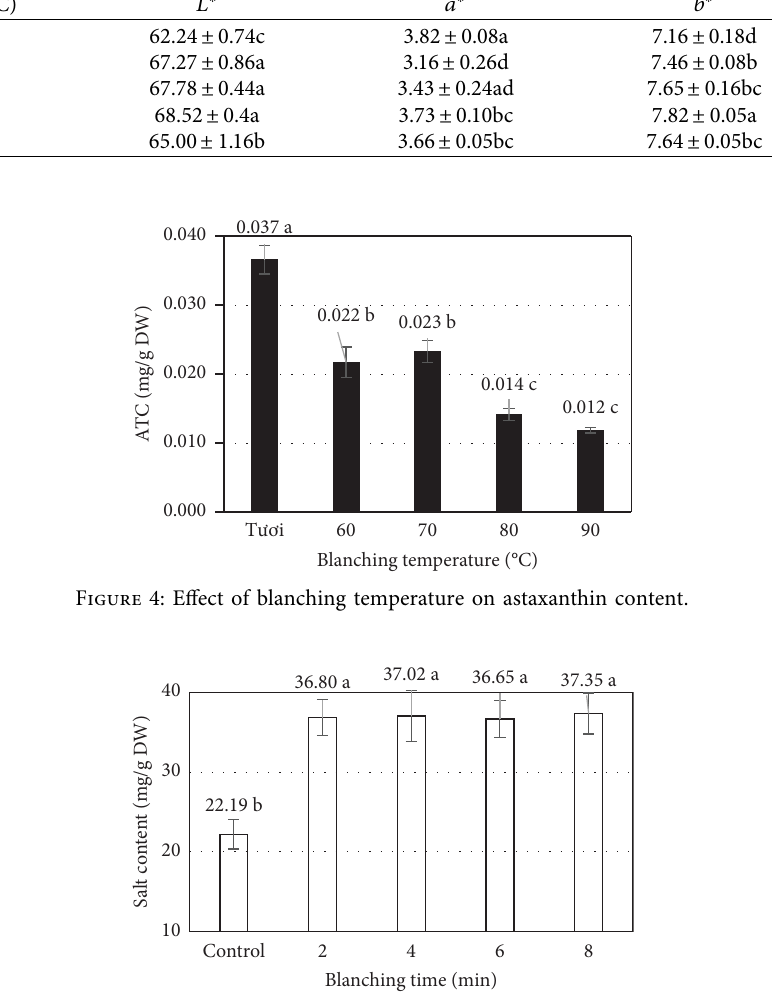
Figure 5: Efect of blanching time on salt content. Table 3: Efect of blanching time on